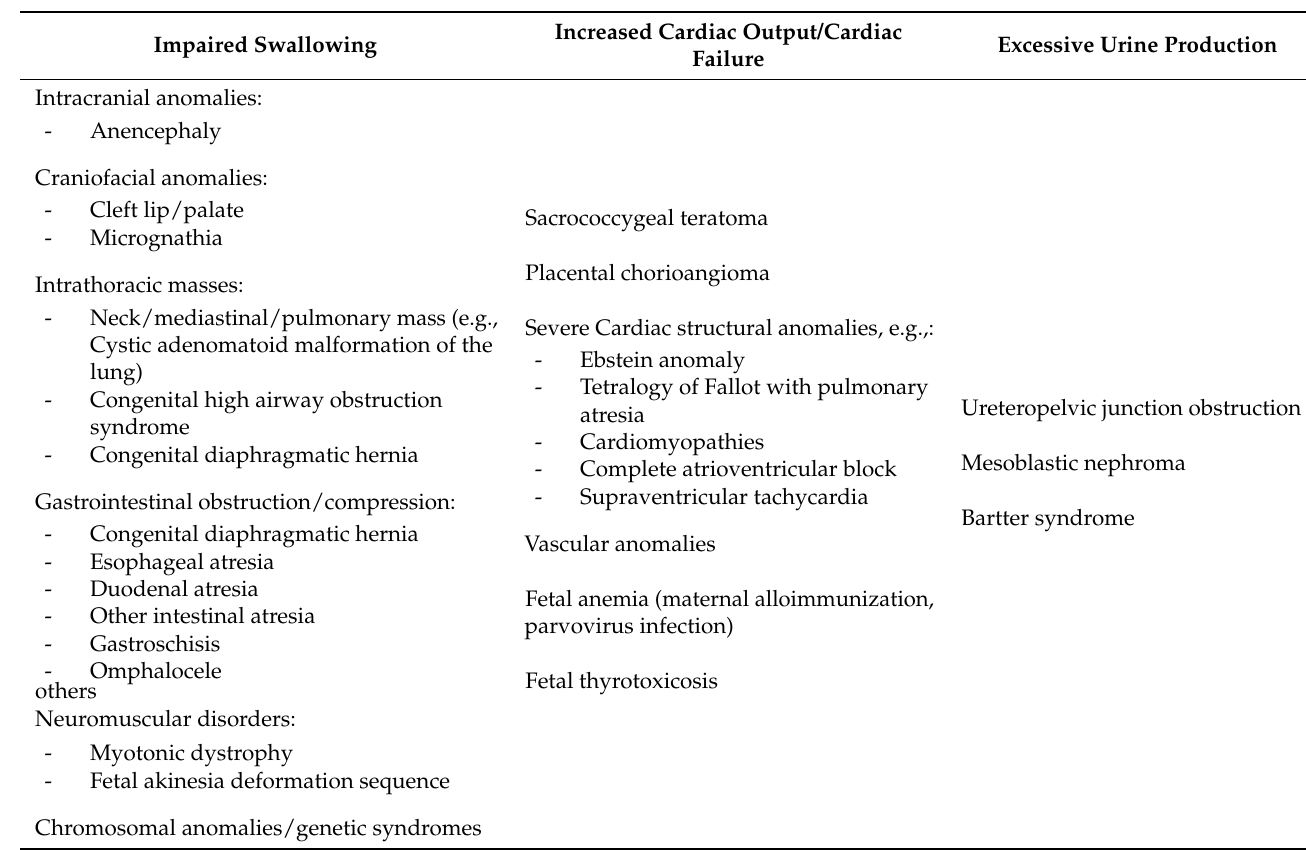
Table 4. Fetal anomalies that can cause polyhydramnios, classified by the mechanisms that determine the amniotic fluid